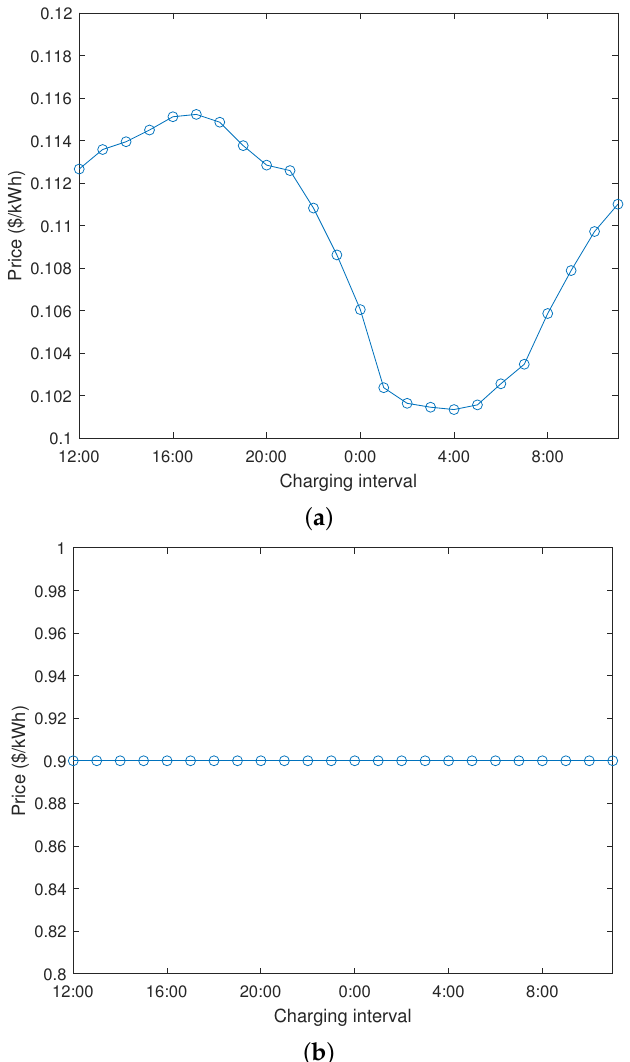
Figure 4. CommonelectricitypriceupdatesforAlgorithm1. ( a )Withoutreplayattack; ( b